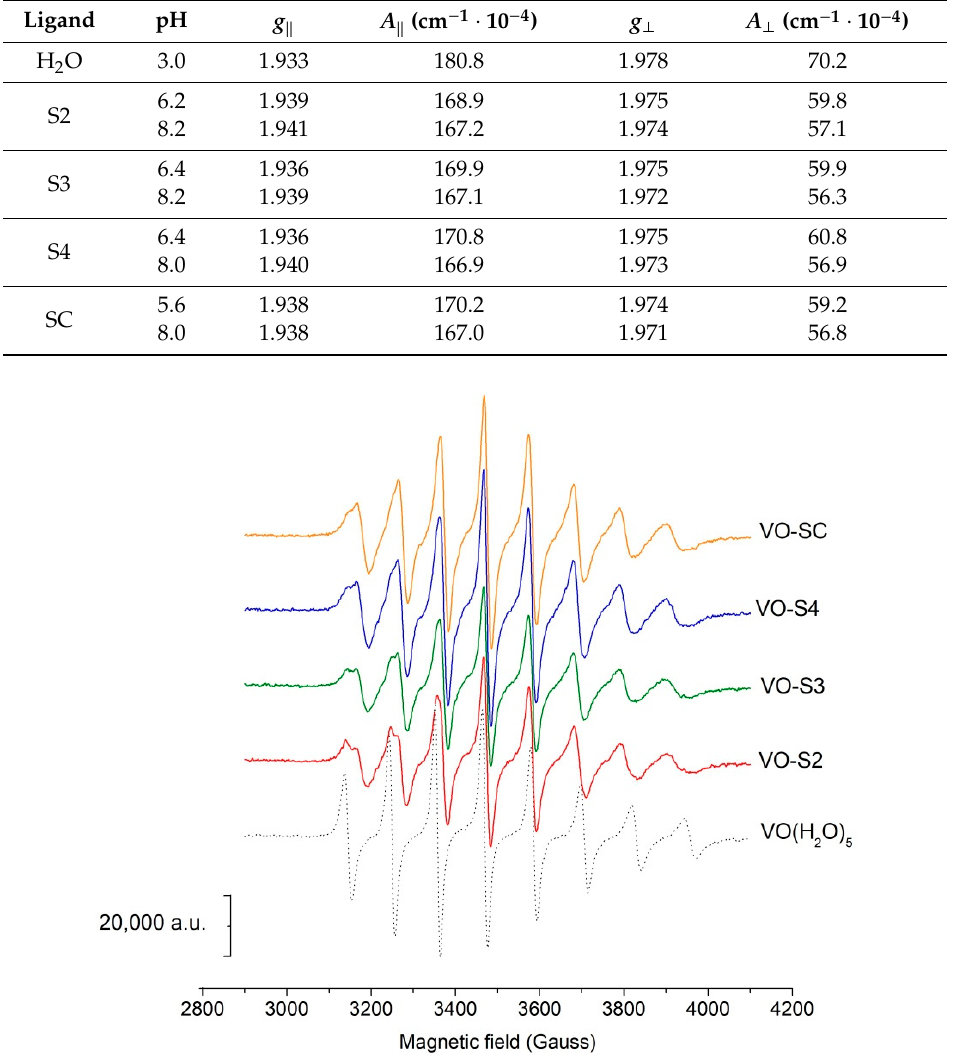
Table 4. LT EPR data. Anisotropic magnetic parameters obtained by fitting the experimental frozen solution spectra of the oxovanadium(IV) species with ka derivatives at different pH values. Anisotropic magnetic parameters for the oxovanadium(IV) cation in water at pH 3 are also shown for comparison. Errors in g and A values were estimated to be ±0.002 and ±0.5 × 10 -4 cm -1 , respectively.